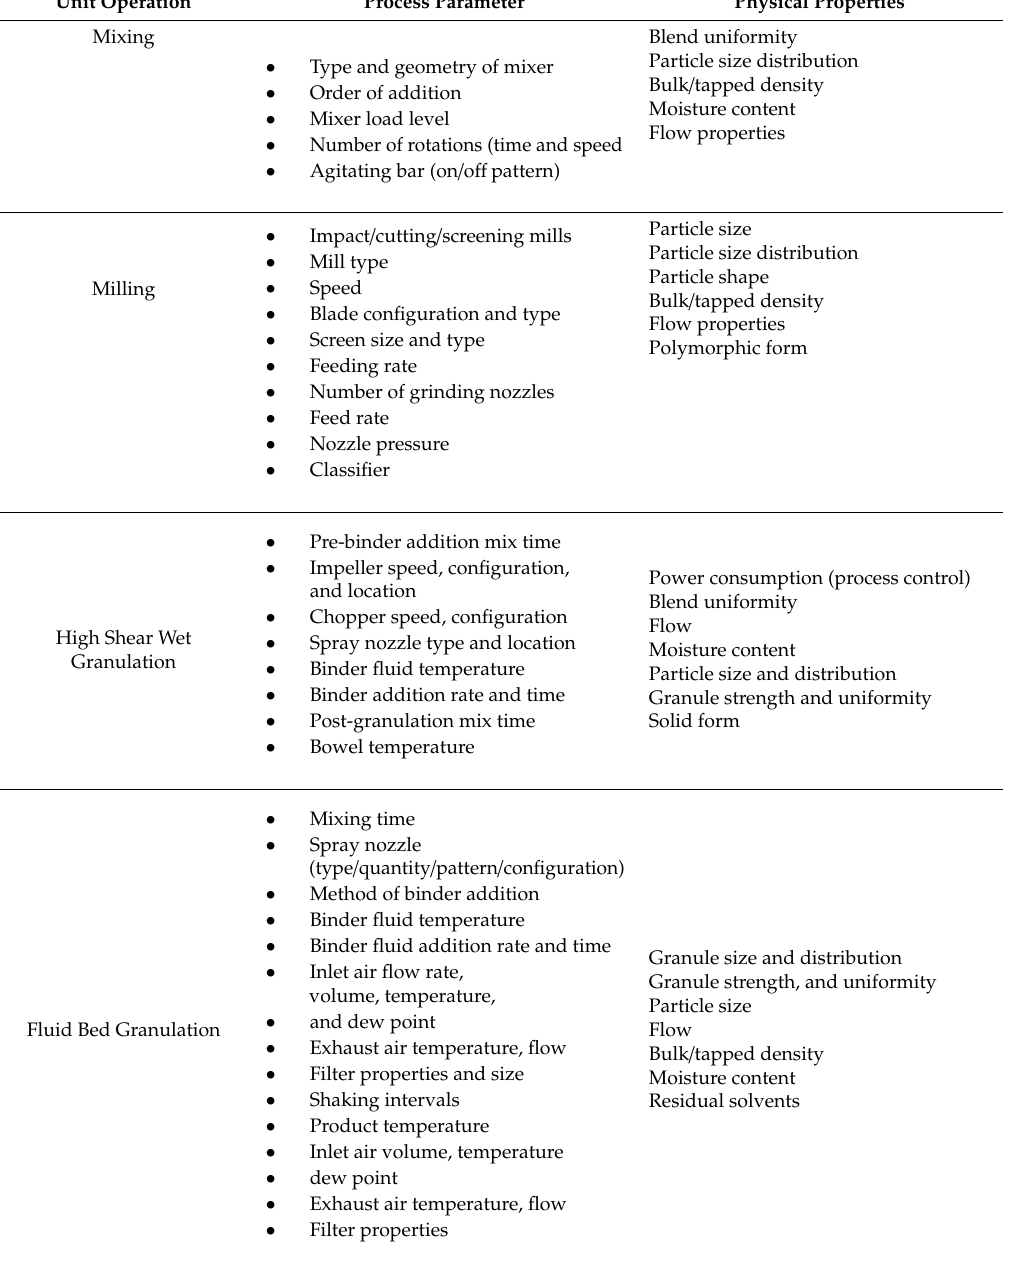
Table A1. Tablet Processing